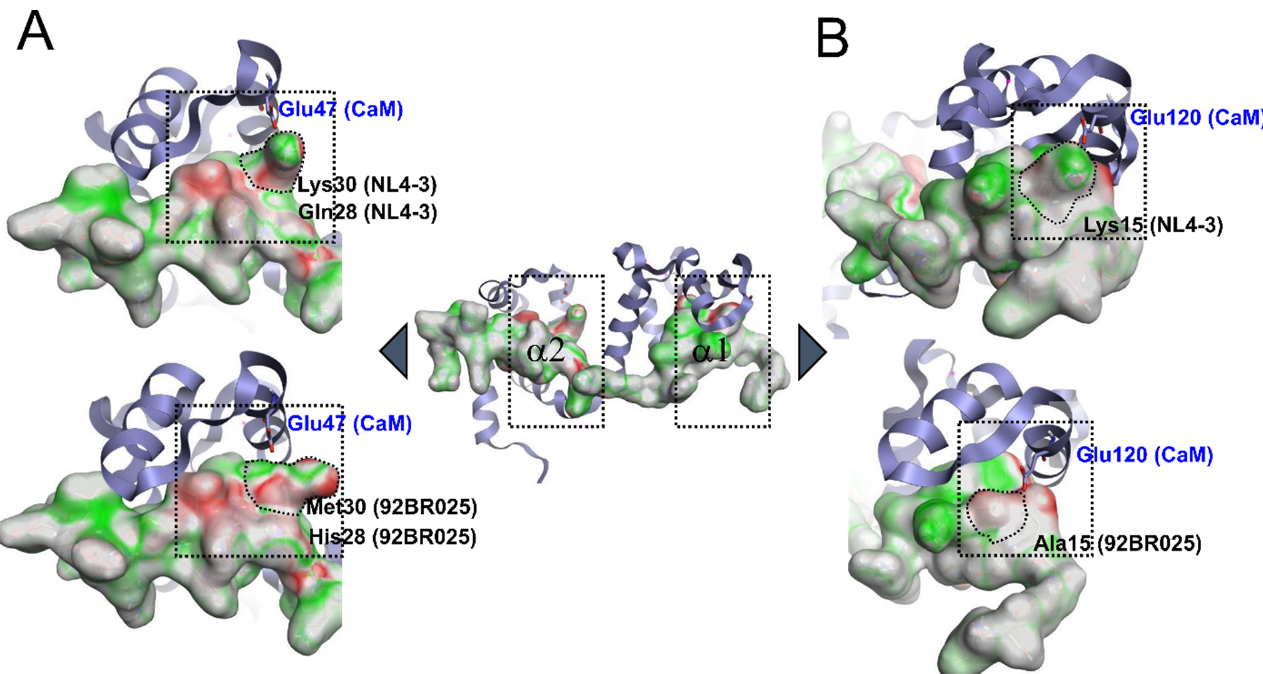
Figure 5. Electrostatic complementarity (EC) of the CaM binding motif of HIV-1 MA (residue 8–43) bound to rnCaM (PDB code: 2MGU). ( A ) Native complex and an ( B ) in silico mutated and minimized HIV-1 MA. Regions of the HIV-1 MA surface where there is perfect electrostatic complementarity with the protein are colored green, while the regions where there is a perfect electrostatic clash are colored red. RnCaM is displayed in ribbon, and HIV-1 MA (residue 8–43) is surface representation. Mutations that altered electrostatic complementarity and abrogated salt bridge interactions to Glutamates are outlined (Lys30Met, Lys15Ala). HIV-1 MA (8–43) clade B (NL4-3) complementarity score: 0.14; HIV-1 MA (8–43) clade C (92BR025.8) complementarity score: 0.12.